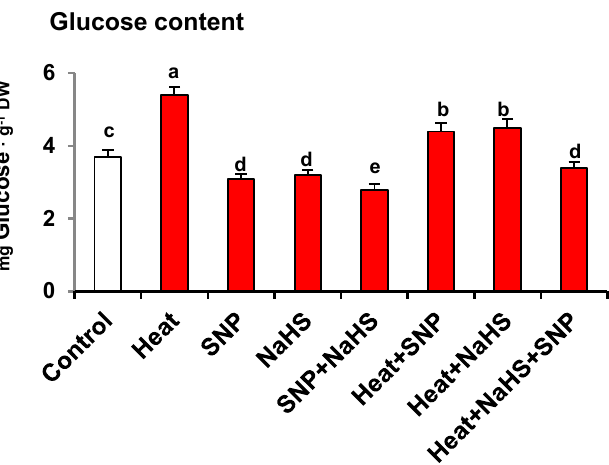
Figure 3. Glucose content in wheat ( Triticum aestivum L. var. WH 542) leaves treated with SNP (100 µM) and/or NaHS (200 µM) in the presence (40 °C) or absence (25 °C) of heat stress at 30 days after sowing (DAS). Data are presented as treatments mean ± SE ( n = 4). Data followed by the same letter are not significantly different by LSD test at ( p < 0.05). DW, dry weight; SNP, sodium nitroprusside; NaHS, sodium hydrosulfide.